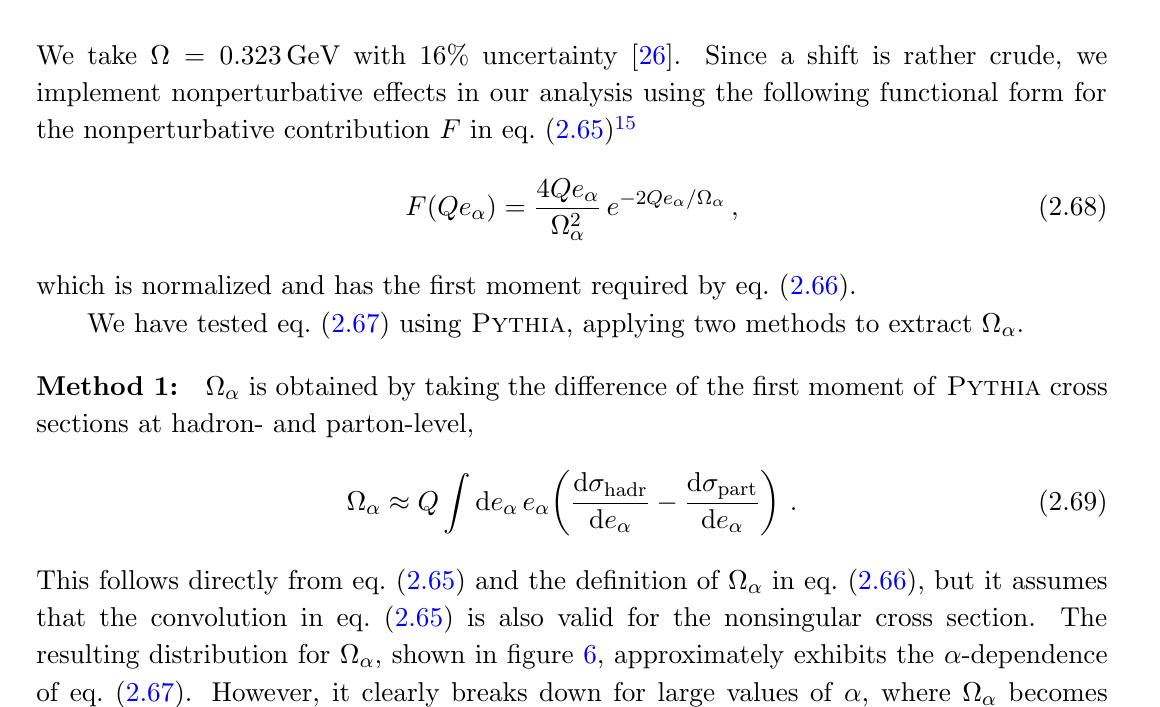
Figure 6 . The leading nonperturbative parameter (cid:10)